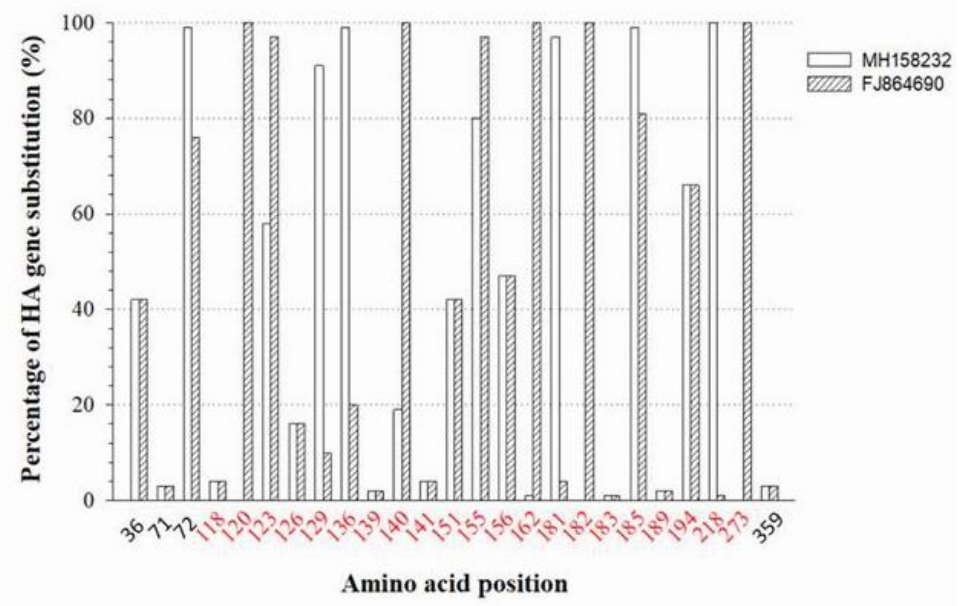
Figure 5. Amino acid substitutions at the known antigenic sites of the H5 HA protein. The degree of amino acid substitutions is summarized from 106 H5 HA genes of Mexican H5N2 AIVs collected between 2016 and 2019 against H5 HA proteins of the vaccine strain A/chicken/Guanajuato/CPA-20966-15-VS/2015 (gene accession no. MH158232) and the recombinant NDV vector vaccine strain A/chicken/Mexico/435/2005 (gene accession no. FJ864690). The residues located within the receptor-binding domain are colored in red.